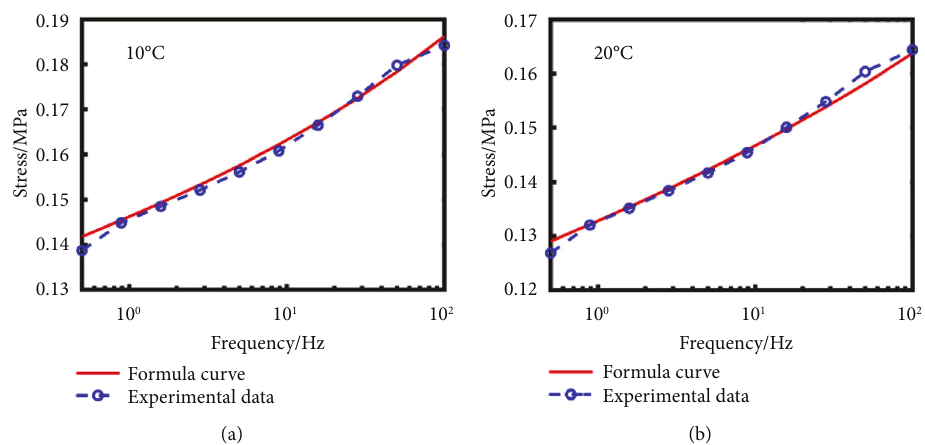
Figure 7: (a) By comparing the stress formula curve at 10 ° C with the test data, R -square=0.9305. (b) R -square=0.8564 is obtained by comparing the stress formula curve at 20 ° C with the test